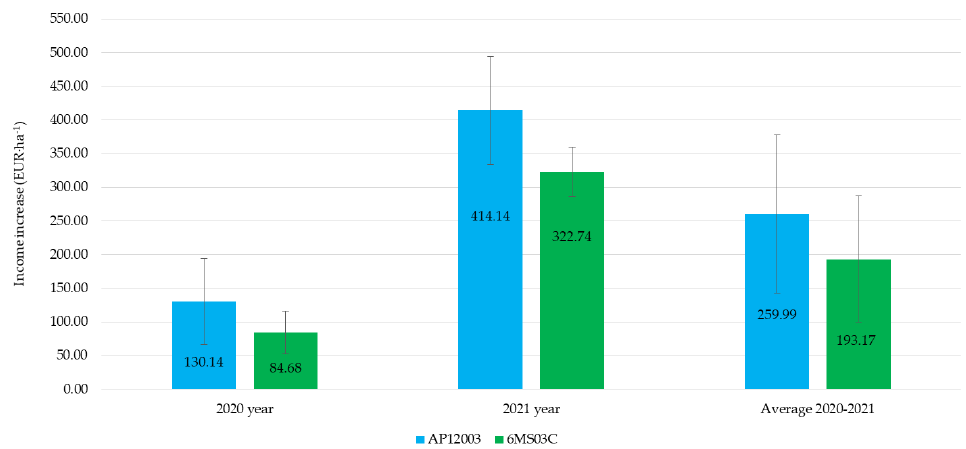
Figure 5. The economic effects of biostimulant application using selected sprayers.